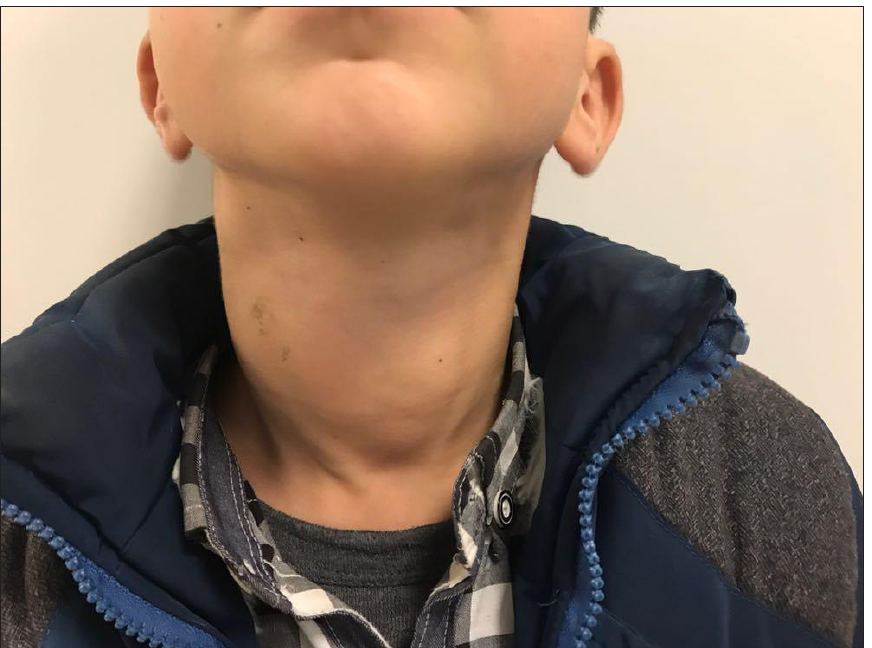
Figure 1. Physical examination. Anterior neck masses due to the thyroid and cervical lymph node involvement. a